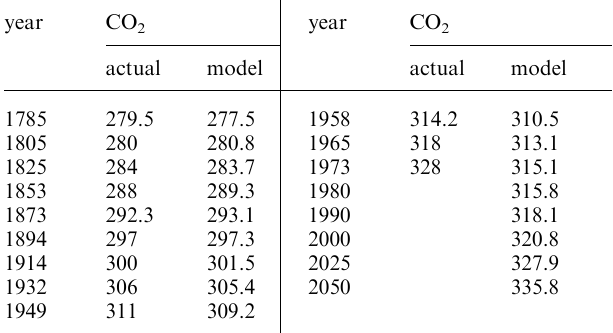
concentration 2